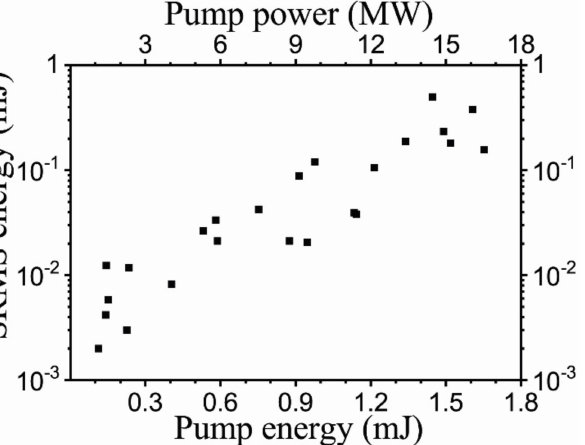
Figure 9. Backscattering efficiency for 0.003 M Ag nanoparticle solution in toluene for the 100 ps pump laser pulse, the threshold is ~0.1 mJ. Experimental points are shown by rectangles. The dependence of spectral shifts of anti-Stokes backscattered 2PA SRMS signal in Ag nanoparticle colloid (0.003 M) in toluene on the picosecond pump pulse energy is shown in Figure 11. This figure looks similar in shape with the analogous dependence for nanosecond pulse scattering in the same colloid. Note, however, that the shifts values in picosecond scattering are ~50 times larger than those for nanosecond pulses. The maximum value is ~0.25 cm − 1 which is almost as high as for the SBS frequency shift but has the opposite sign (in Ag nanoparticle colloid in toluene, SBS reveals as the Stokes shifted signal while 2PA SRMS reveals as the anti-Stokes signal). For the points at sufficiently high pump pulse energies in the right-hand side of Figure 11, the signal and the pump spectra almost overlap with each other but can be rather well separated on interferogram due to sufficiently high power of the backscattered